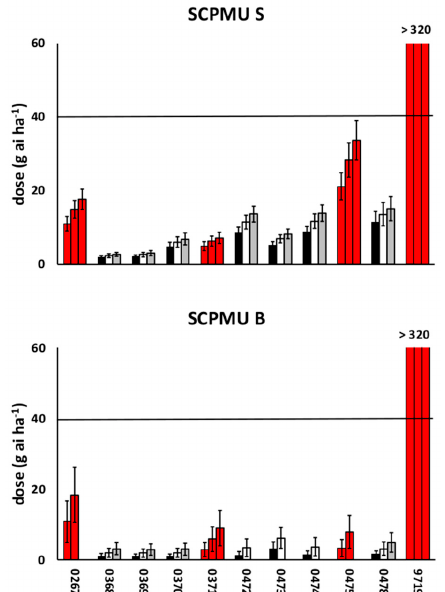
Figure 6. Estimation of ED 50 , ED 80 , and ED 90 (ED 50 and GR 50 black bars, ED 80 , and GR 80 white bars and ED 90 and GR 90 grey bars) of penoxsulam for plant survival (S) and fresh biomass reduction (B) of populations of Schoenoplectus mucronatus (SCPMU). Red bars indicate populations resistant to SUs according to the preliminary screenings. Populations 9719 and 0267 are ALS-resistant checks. Due to high variability, GR 90 of populations 0267 0472, 0473, 0474, and 0475 are not reported. Vertical bars represent 95% Confidence Intervals. Recommended field dose of penoxsulam (40 g ai ha − 1 ) is represented by the horizontal black line.